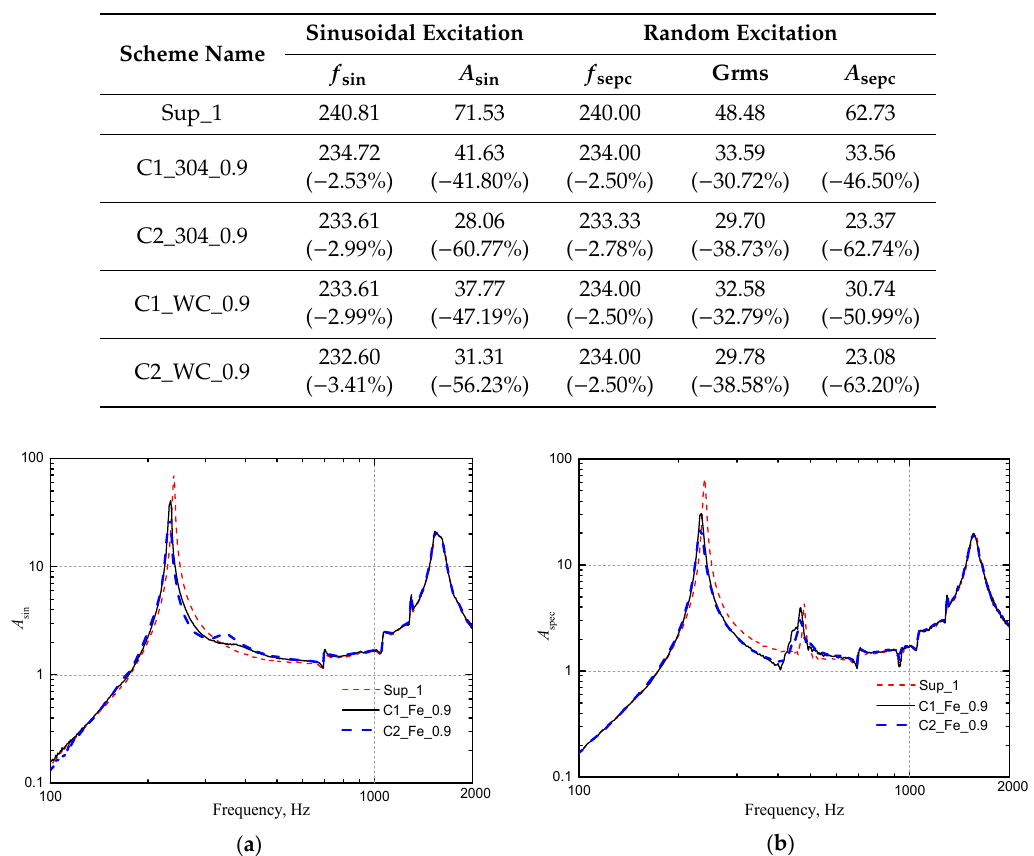
Table 7. E ff ect of layering in Y-direction of the cavity.